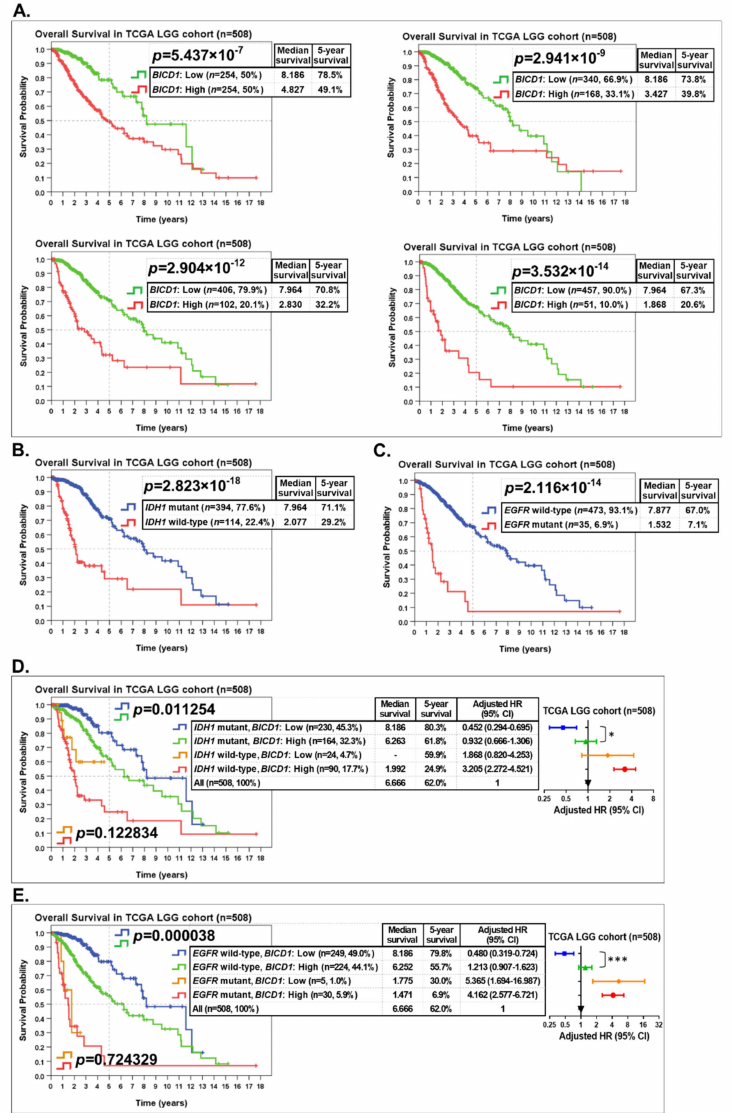
Figure 5. The prognostic role and significance of BICD1 downregulation and the improvement in prognostic accuracy when BICD1 expression was incorporated with IDH1 or EGFR mutation status to stratify LGG patients. ( A ). The Kaplan–Meier survival analyses revealed the prognostic role and significance of BICD1 downregulation when patients in the TCGA LGG cohort were stratified into two groups depending on their BICD1 expression (50% high vs. 50% low, 33.1% high vs. 66.9% low, 20.1% high vs. 79.9% low, and 10.0% high vs. 90.0% low, respectively). ( B ). The prognostic role and significance of IDH1 status in LGGs. ( C ). The prognostic role and significance of EGFR status in LGGs. ( D ). The improvement in prognostic accuracy when BICD1 expression was incorporated with IDH1 status to stratify LGG patients into four subgroups. The four subgroups of LGGs stratified by IDH1 status and BICD1 expression were ranked according to their HRs. ( E ). The improvement in prognostic accuracy when BICD1 expression was incorporated with EGFR status to stratify LGG patients into four subgroups. The four subgroups of LGGs stratified by EGFR status and BICD1 expression were ranked according to their HRs. In ( D , E ), the symbols “*” and “***” denote statistical p < 0.05 and 0.001,